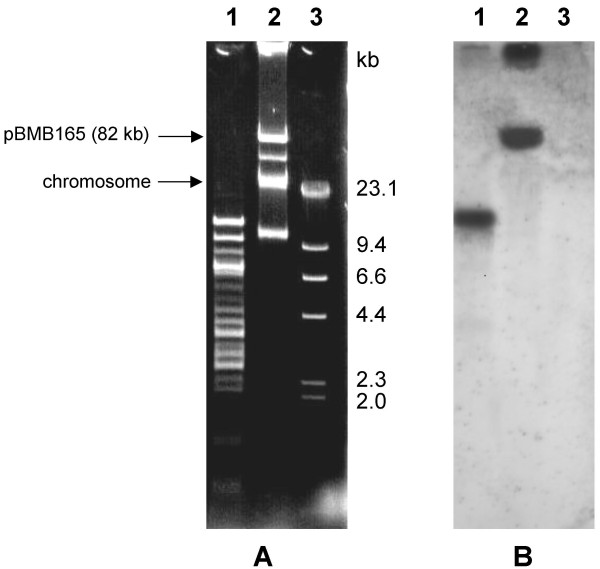
Localization of a plasmid replicon in native plasmids from YBT-1765. (A) Profile of agarose gel electrophoresis. (B) Southern blot with the 12 kb EcoRI fragment from pBMB1651 as probe. Lane 1, the total plasmid of YBT-1765 digested with EcoRI; Lane 2, the total plasmid of YBT-1765; Lane 3, λ HindIII marker.